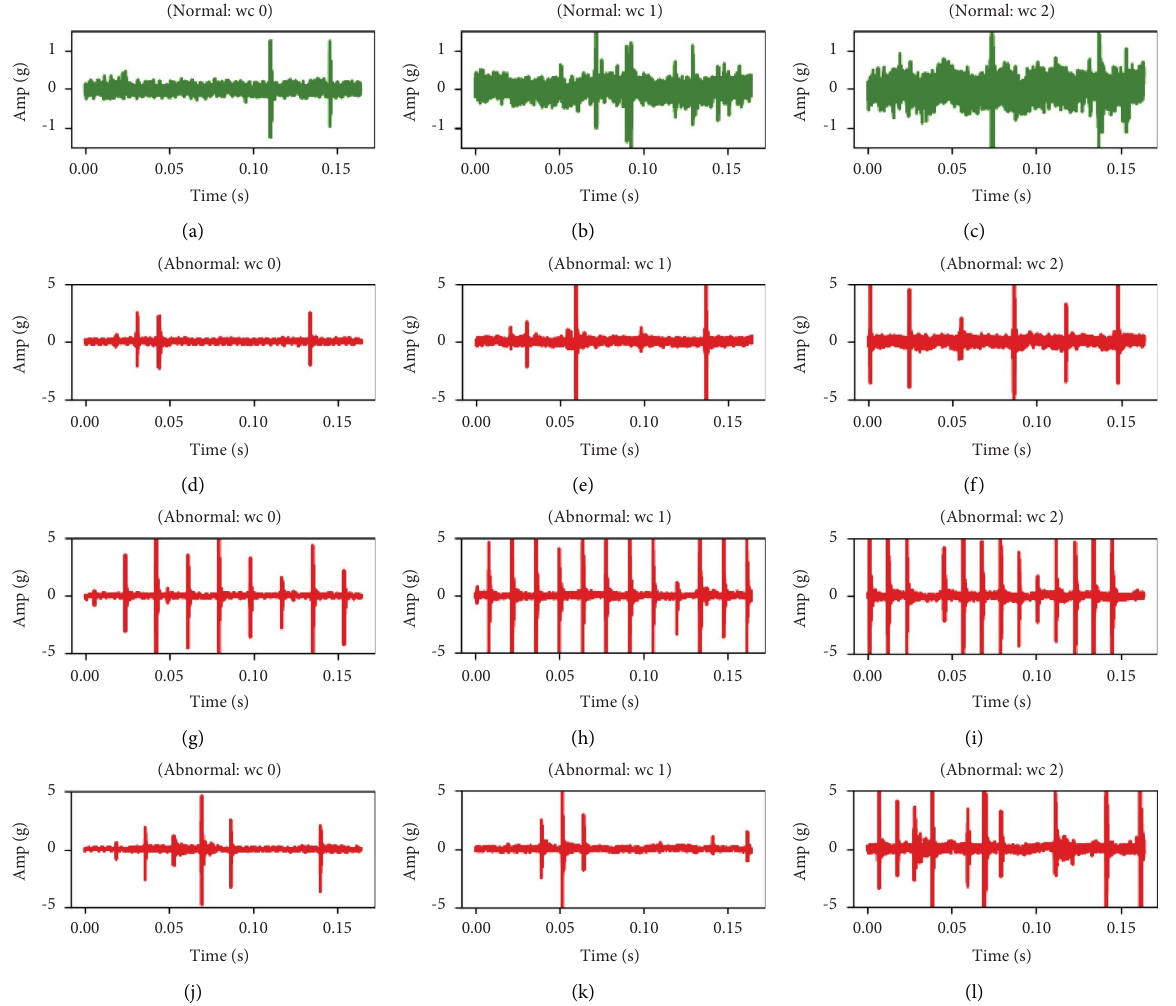
Figure 1: Examples of multiple working conditions (data from JNU dataset. “wc” is short for working condition). (a) Normal: wc 0. (b) Normal: wc 1). (c) Normal: wc 2). (d) Abnormal: wc 0. (e) Abnormal: wc 1. (f) Abnormal: wc 2. (g) Abnormal: wc 0. (h) Abnormal: wc 1. (i) Abnormal: wc 2. (j) Abnormal: wc 0. (k) Abnormal: wc 1. (l) Abnormal: wc